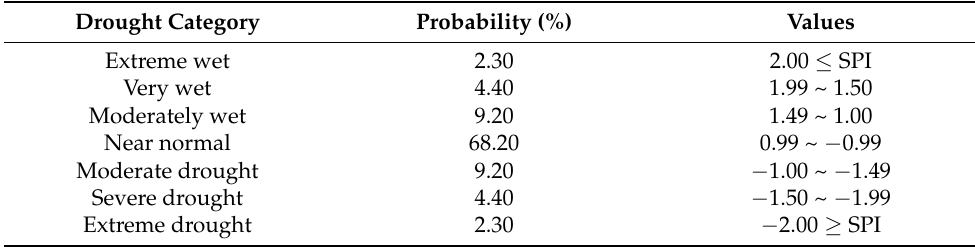
Table 2. Classification of SPI